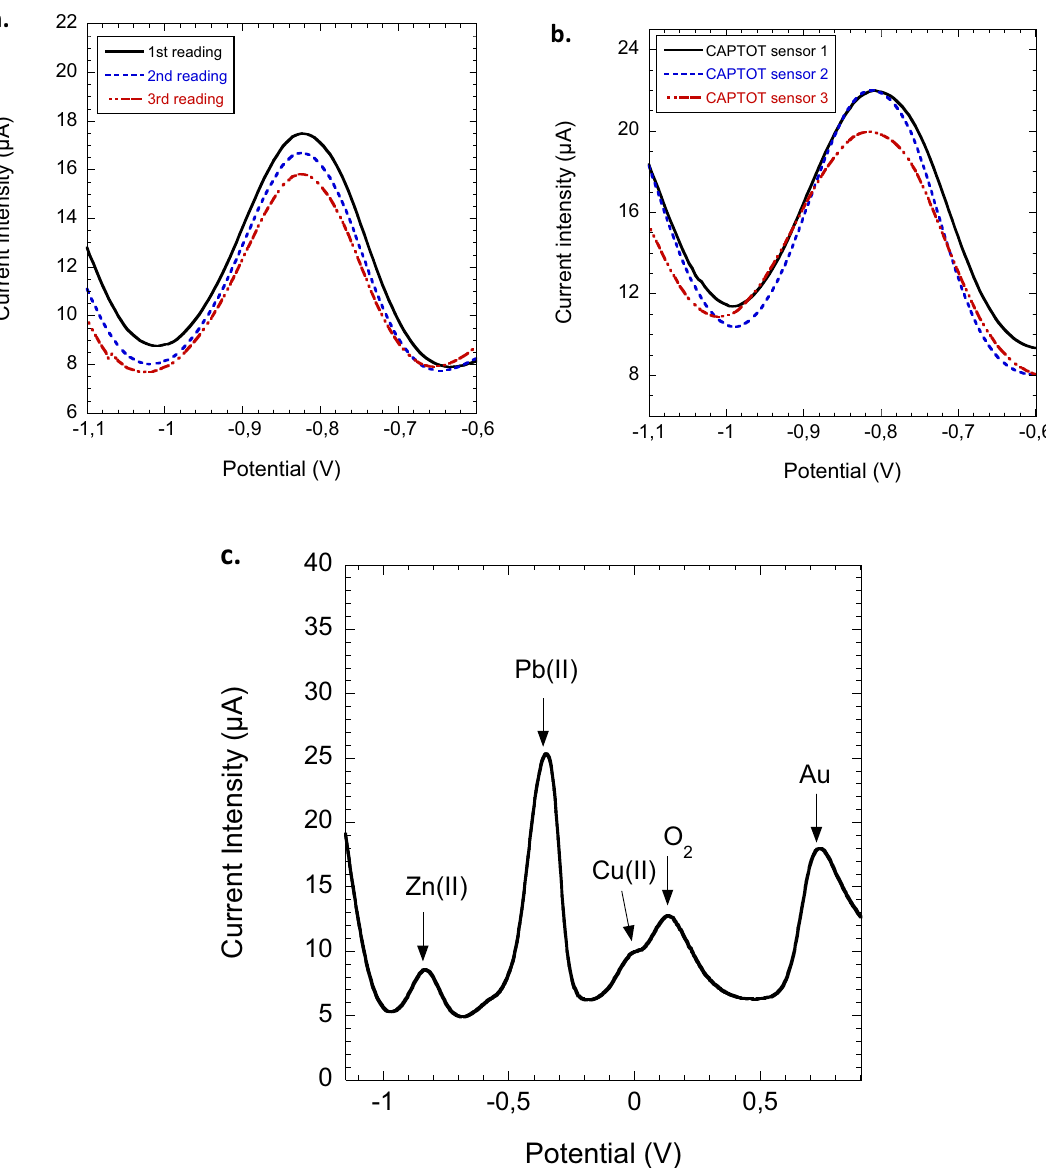
Figure 8. ( a ) Repeatability test: multiple SW-ASV voltammograms registrations obtained with the same presorbed Zn(II) PAA-g-PVDF nanoporous membrane-electrode; ( b ) reproducibility test: triplicate experiments utilizing three different batches of PAA-g-PVDF nanoporous membrane-electrodes—for ( a ) and ( b ) tests, presorptions were performed in 200 ppb Zn(II) spiked synthetic water solutions; ( c ) multiple-ion detection: registered SW-ASV voltammogram of a presorbed PAA-g-PVDF nanoporous membrane-electrode in an 1 aqueous solution composed of 50 g L − NaCl, 200 ppb Zn(II), 200 ppb Pb(II) and 200 ppb Cu(II)—Electrolyte: 0.1 M buffered acetate, pH